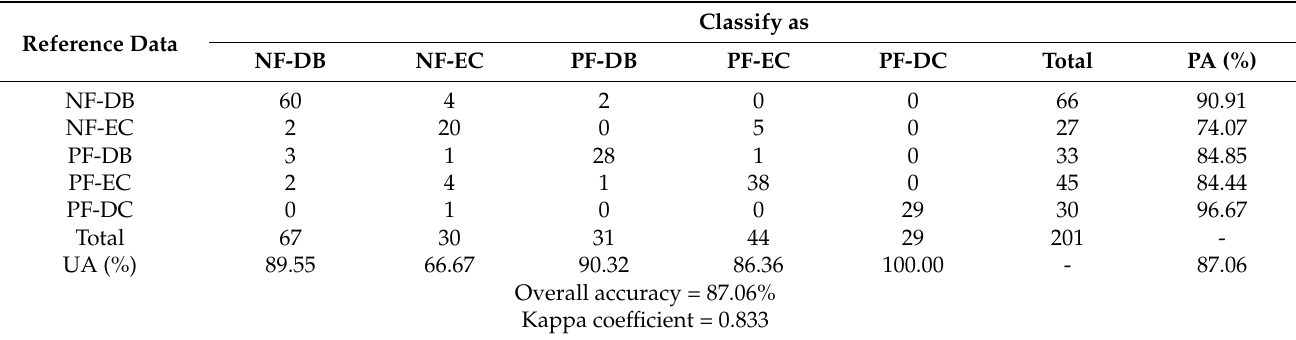
Figure 8. Prediction error of Random Forest model with different ntree. Table 2. Confusion matrix of classification results based on RF for five-forest type classification. (UA: user’s accuracy, PA: producer’s accuracy, OA: overall